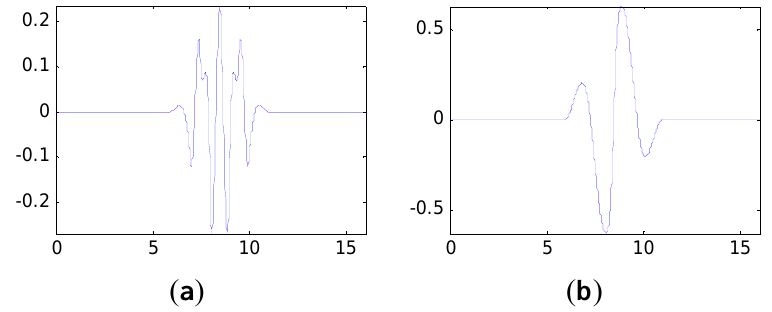
 and  constructed for vibration signal under assembly 1 2  ; ( b )  . 1 2